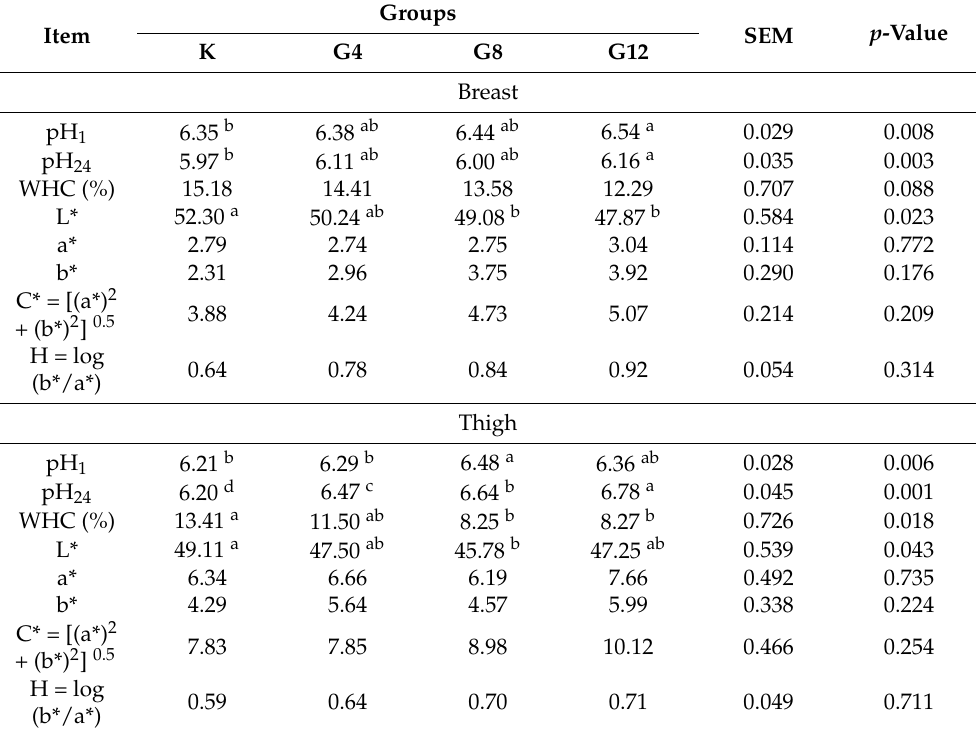
Table 10. Physical properties of muscles of broiler chickens fed graded levels of guar meal. Item